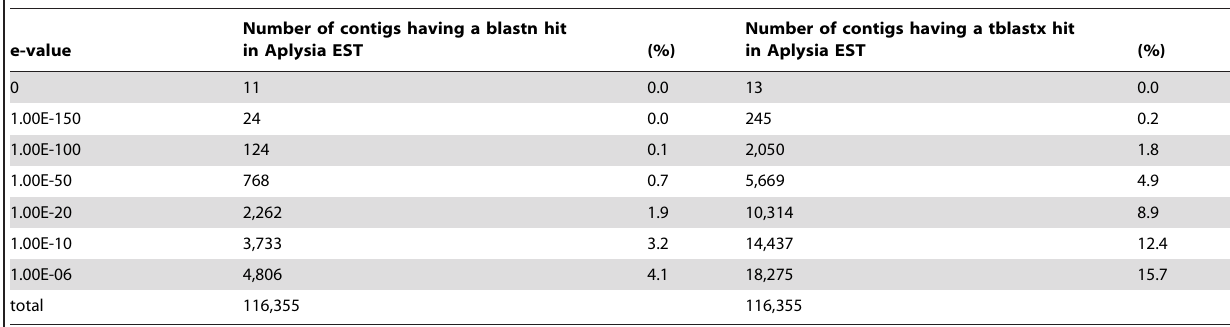
Table 4. Comparison of the Lymnaea TSAs and Aplysia